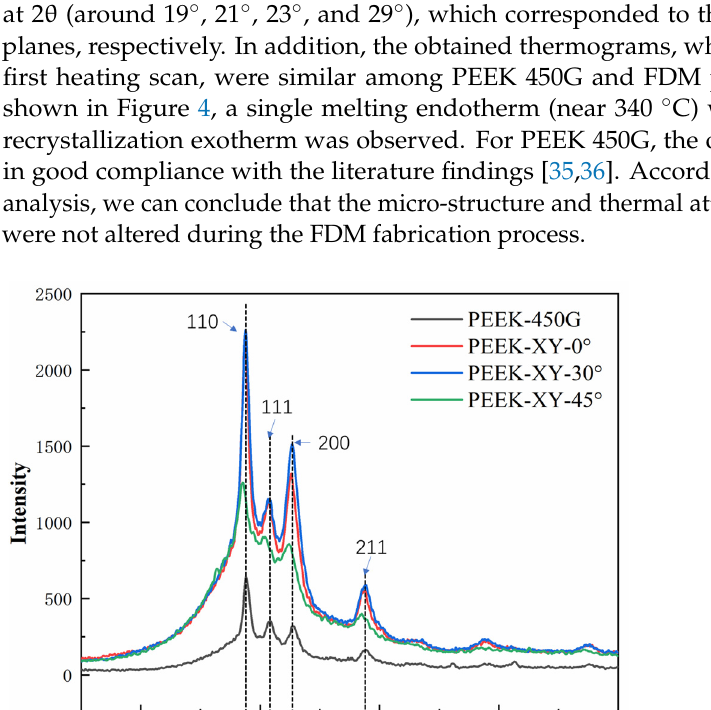
Figure 4. DSC thermograms of PEEK 450G and FDM printed PEEK parts. 3.1.2. Crystallinity The bulk crystallinities of FDM fabricated PEEK were calculated to range from 23.53% to 27.76%. These values are relative smaller than those of the injection molded PEEK 450G (reported as from 31.9% to 40.5%) [36]. However, the obtained I 1146 /I 1598 ratios (as listed in Table 2) indicate FDM fabrication did not lead to significant alteration in the surface layer crystallinity of PEEK. The differences in bulk and surface layer crystallinity results are likely due to the skin and core effect. In addition, the reduction in bulk crystal- linity is probably caused by the utilization of a relative lower bed temperature [18]. PEEK is a linear semi-crystalline thermoplastic, and its mechanical strength is mainly contrib- uted by the crystal phase [37]. The reduction in bulk crystallinity may lead to deterioration in the mechanical performance. Additional post-fabrication thermal treatment can be used to overcome this issue. Table 2. The obtained I 1146 /I 1598 band ratios. Samples